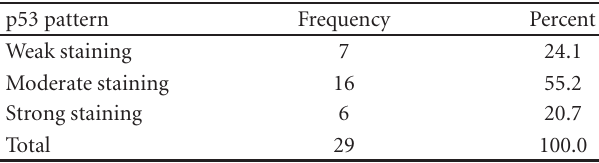
Table 6: p53 expression in the nucleus of the tumor duct